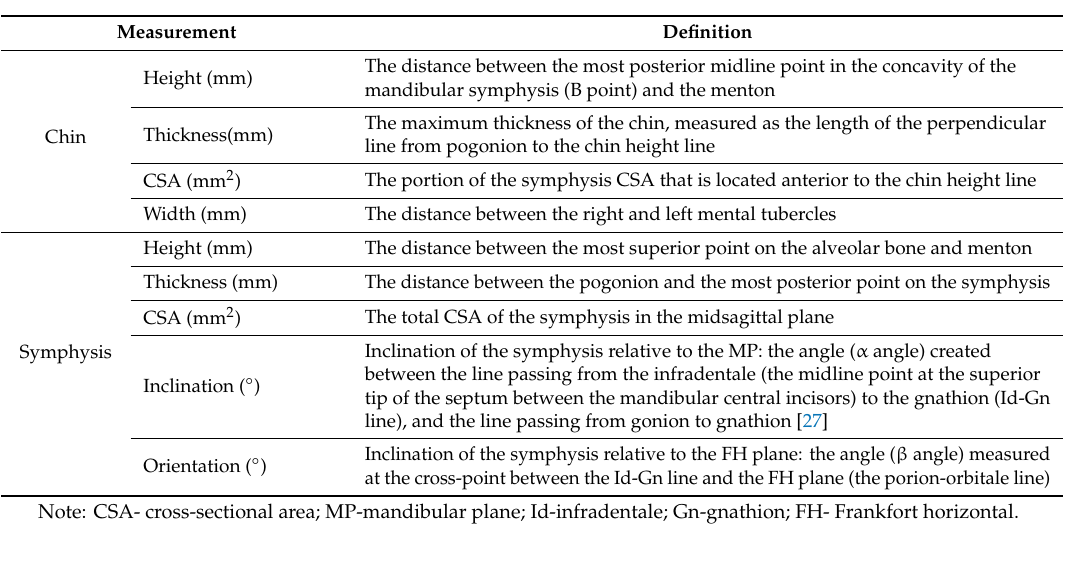
Table 1. Definitions of the chin and the symphysis measurements.